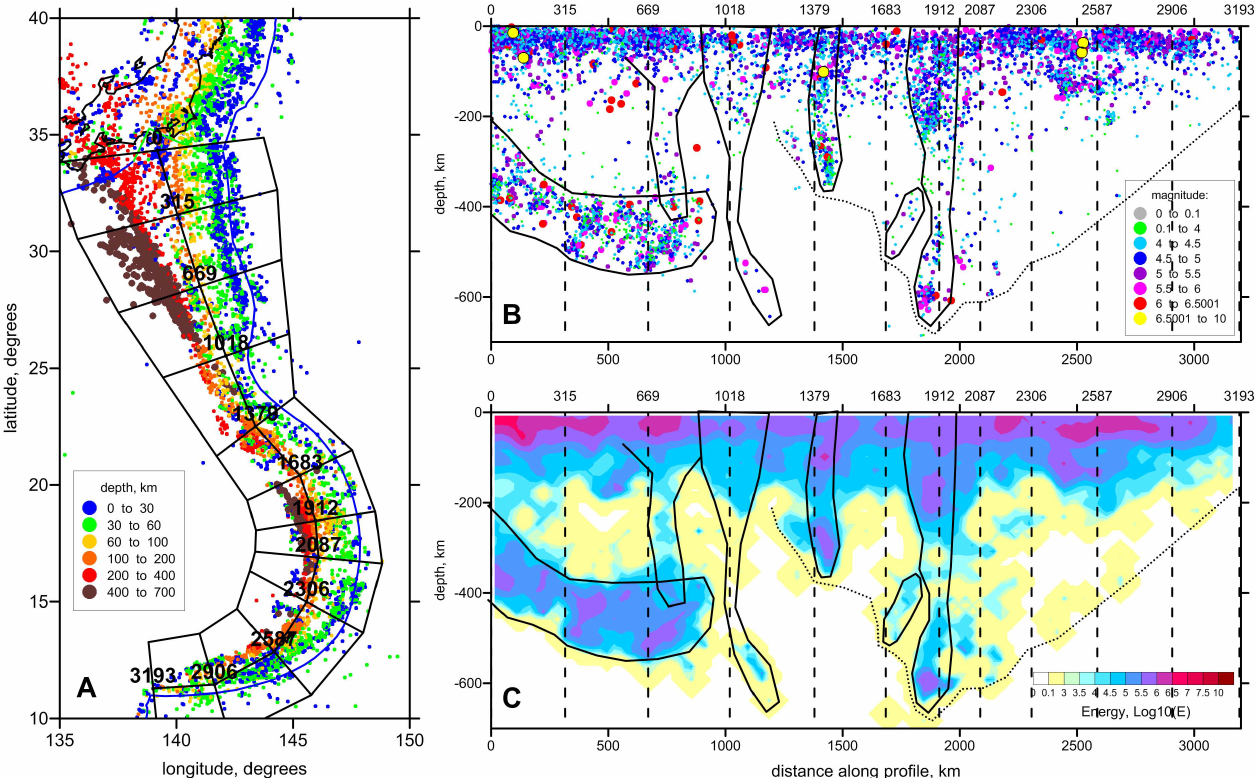
Fig. 2. (A) Distribution of earthquakes in map view. Coloured dots depict earthquake hypocentres. Segments indicate the area in which the seismicity was considered. Line in the centre of the segments is the location of vertical profile for plots B and C. (B) The distribution of earthquakes in the vertical cross-section along the arc; colours and sizes of dots indicate the magnitude of events. (C) Total seismic energy release along the same vertical section in 50 × 50km cells. Black lines in Plots B and C highlight the cluster of earthquakes discussed in the text. Dotted line depicts the bottom of the seismogenic zone beneath the Mariana Arc.